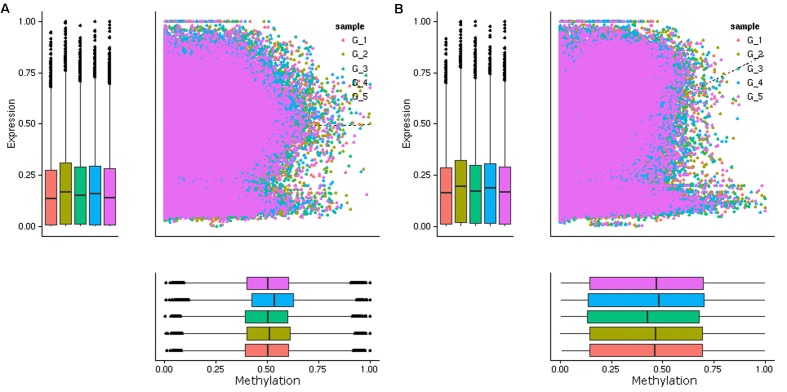
Scatterplot of DNA methylation (x-axis) and gene expression (y-axis) of the DMRs overlapped genes in five groups (G1, G2, G3, G4, and G5). The genes with DMRs in the promoter regions (A) and the gene body regions (B) were presented. A overall positive correlation was observed between the methylation levels in the gene body and the mRNA expression levels of these DMRs overlapped genes, while a overall negative correlation between the methylation levels in the promoter regions and the mRNA expression levels was not observed.